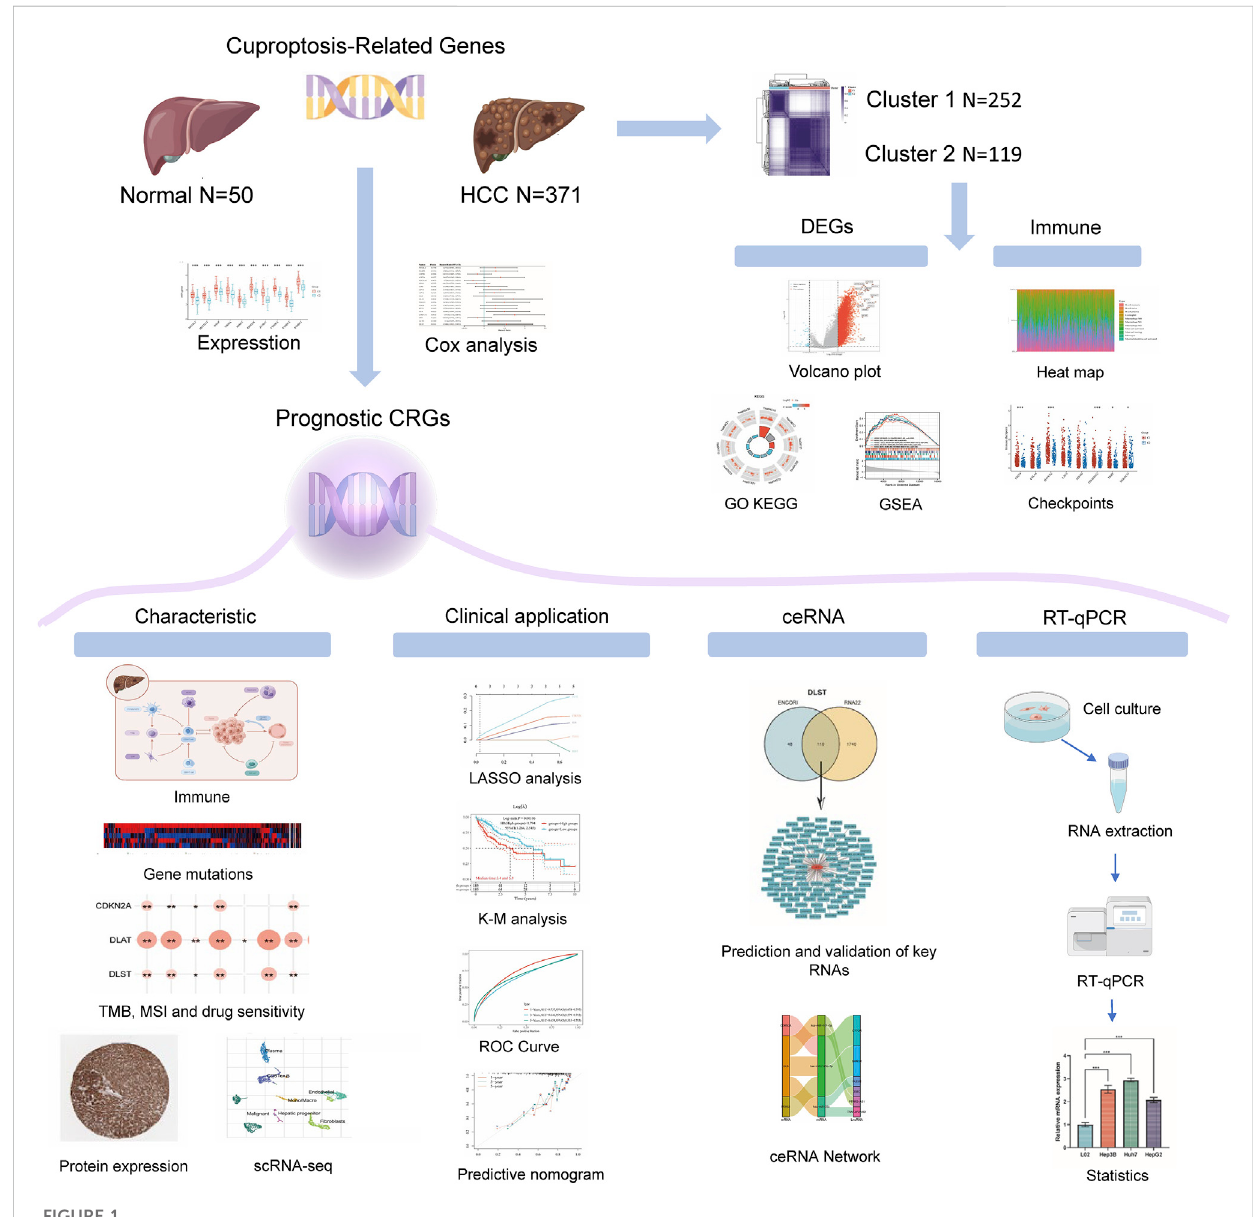
FIGURE 1 The fl owchart of the present